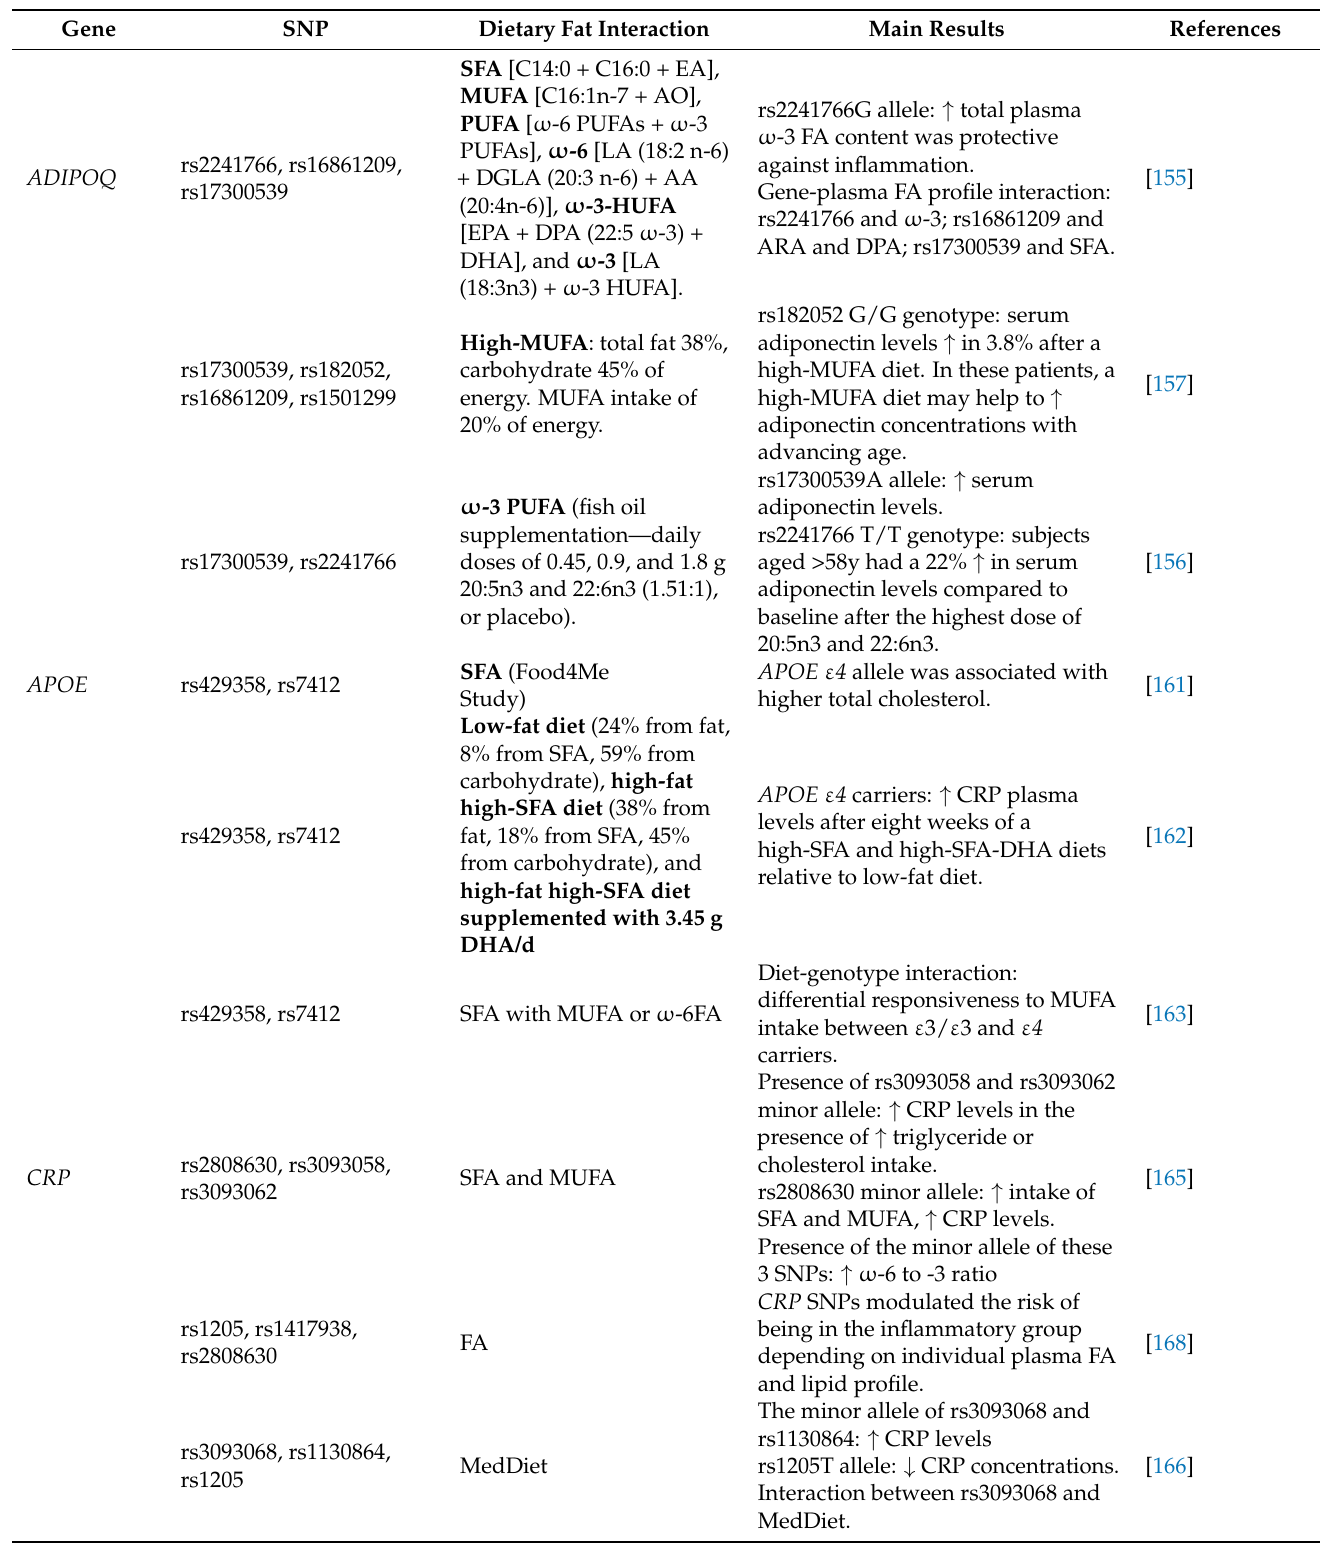
Table 3. Gene-dietary fat interactions mediating inflammation and lipid metabolism. ↑ higher levels; ↓ lower levels. Gene Dietary Fat